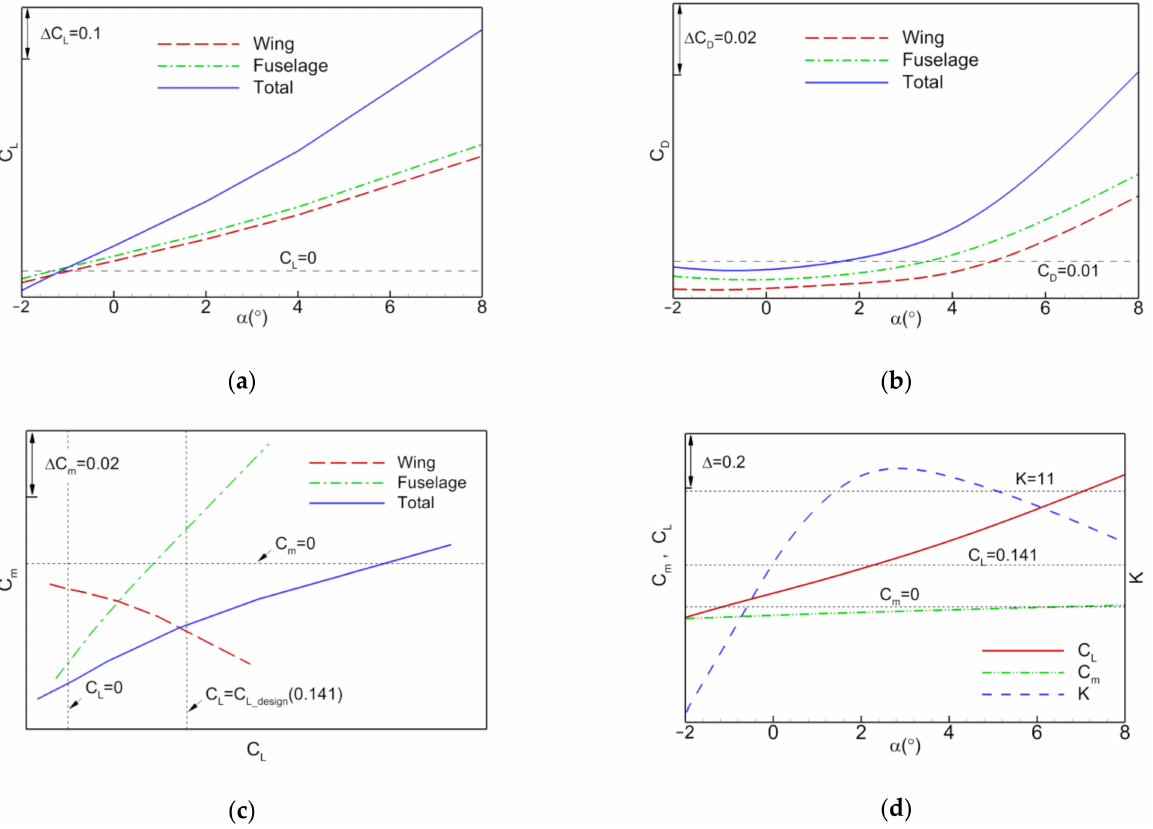
Figure 11. Aerodynamic characteristic of each component and the initial configuration, Ma = 0.85, H = 11 km, α = − 2 ◦ ∼ 8 ◦ , ∆ α = 2 ◦ . ( a ) Lift coefficient; ( b ) Drag coefficient; ( c ) Pitching moment coefficient; ( d ) Aerodynamic characteristic of the initial